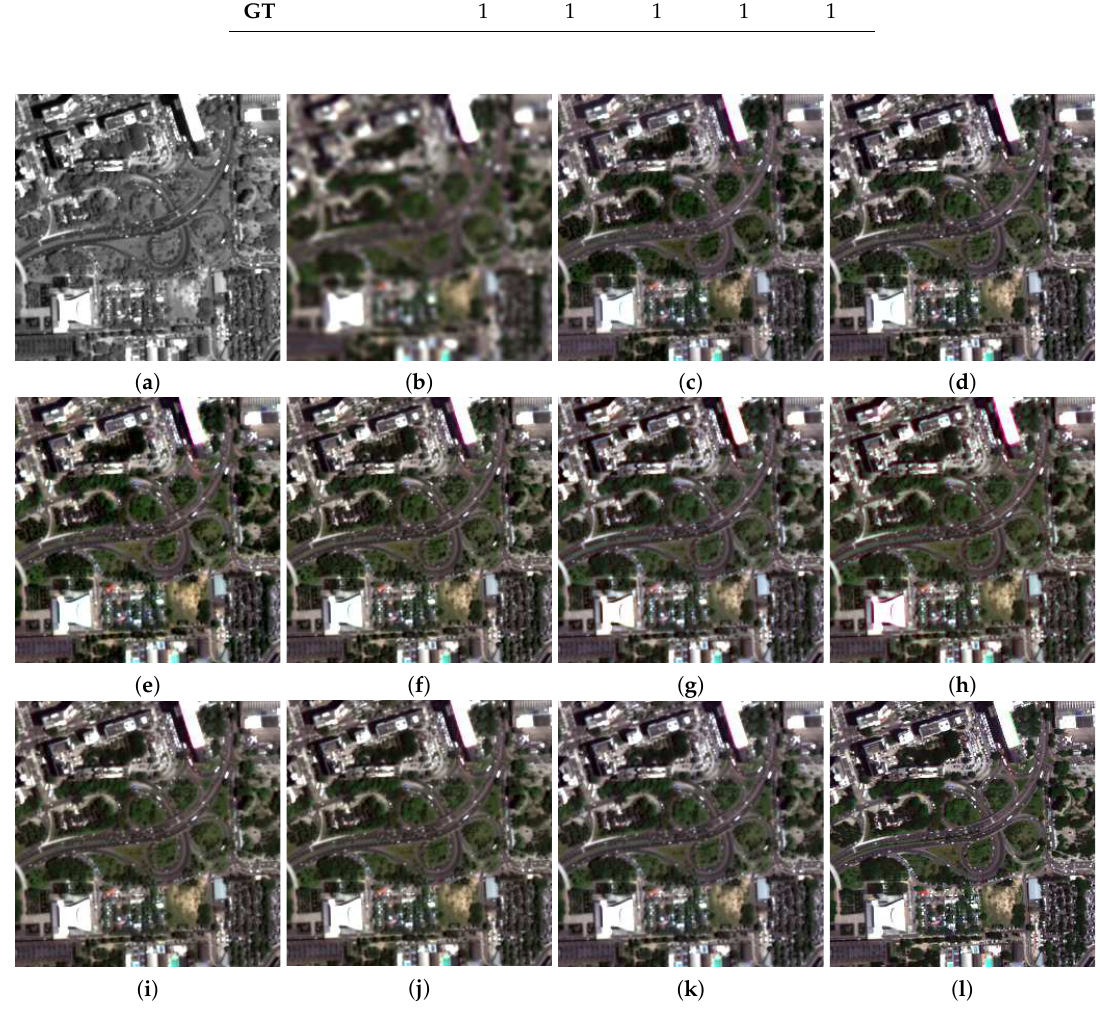
Figure 7. Panchromatic and true-color compositions of 256 × 256 detail of 2 m